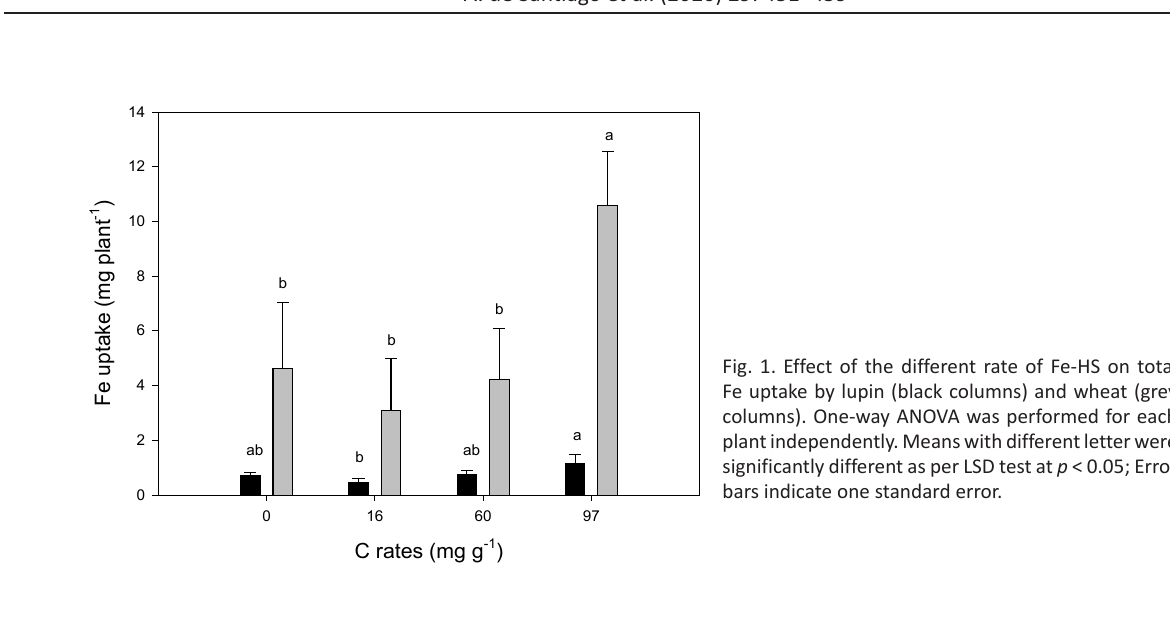
Table 2. Effect of different amounts of humic substances adsorbed on ferrihydrite on the chlorophyll meter readings (SPAD), dry matter (DM) yields, Fe concentration in aerial parts and roots, and the total amount of Fe in aerial parts and roots of lupins and wheat grown on a calcareous growing medium Lupin Wheat